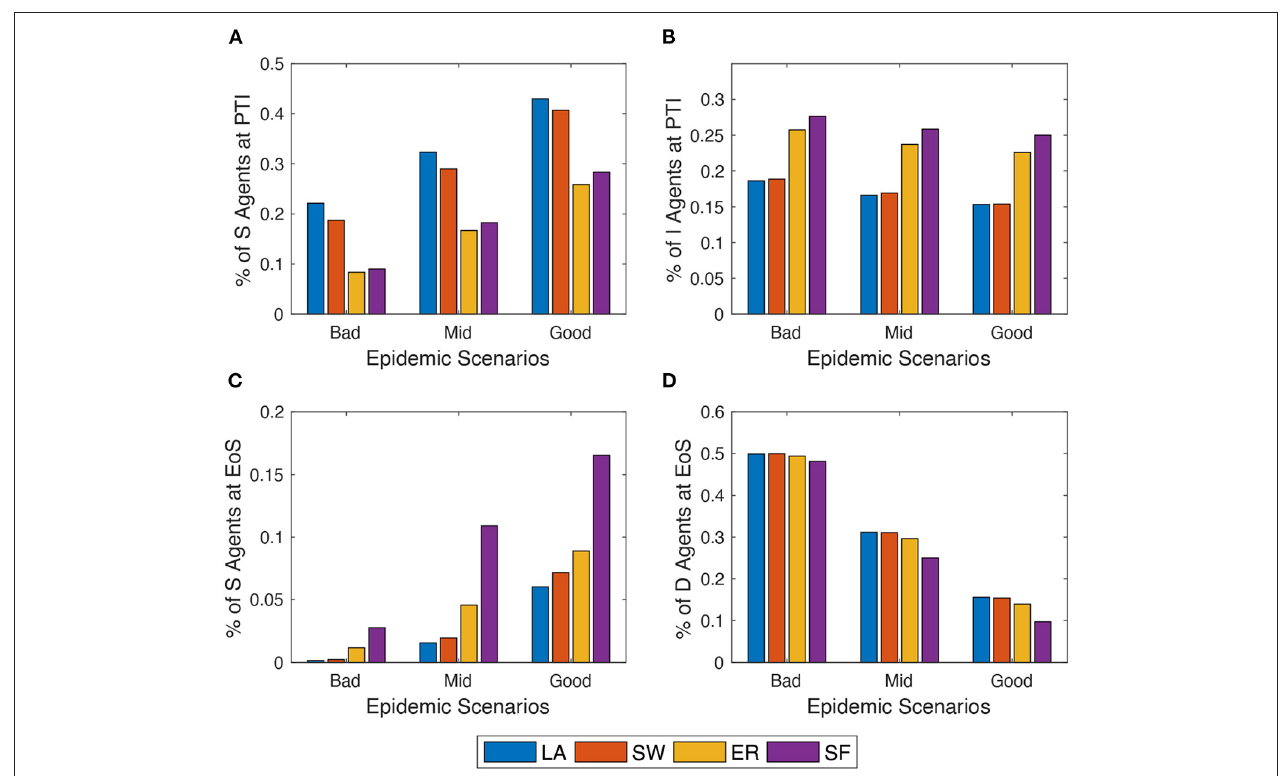
FIGURE 4 | Comparing the behavior of the model across three epidemic scenarios: Bad vs. Mid vs. Good (see Section 2.3). (A) and (C) % of agents in compartment S at peak-time of infections (PTI). (B) % of agents in compartment I at the end of the simulation (EoS). (D) % of agents in compartment D at the EoS. Initial average degree: ¯ k = 8. Averages across M = 1,000 Monte Carlo